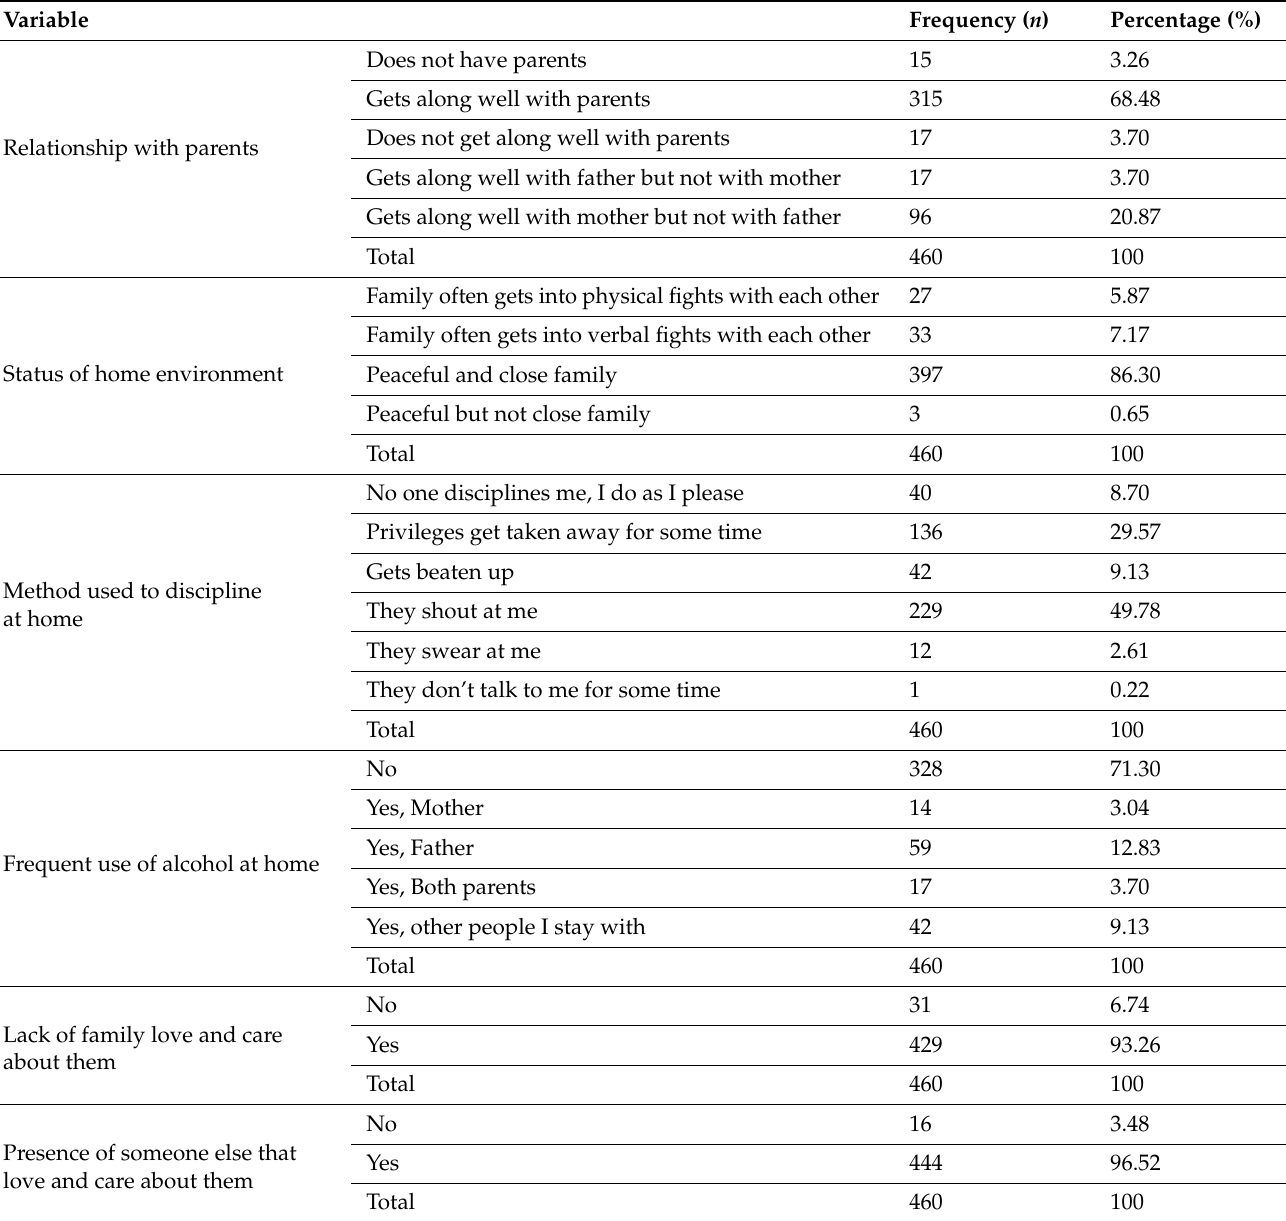
Table 1. The socio-demographic characteristics of the respondents ( n =